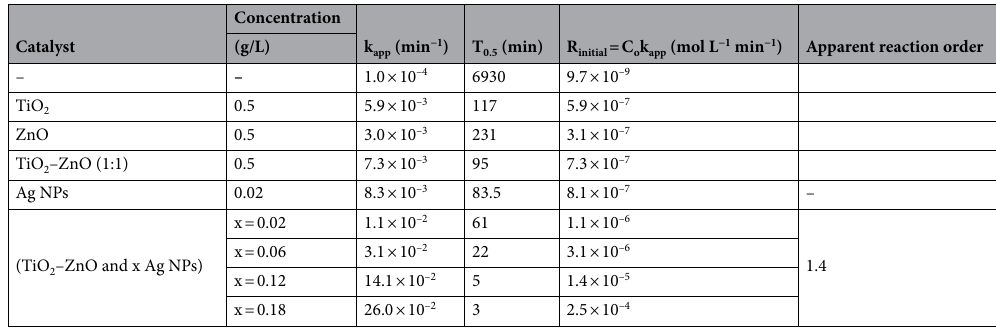
Table 1. Kinetic parameters for the photocatalytic degradation of 1.0 × 10 –4 M acid red 37 dye, upon UV irradiation.